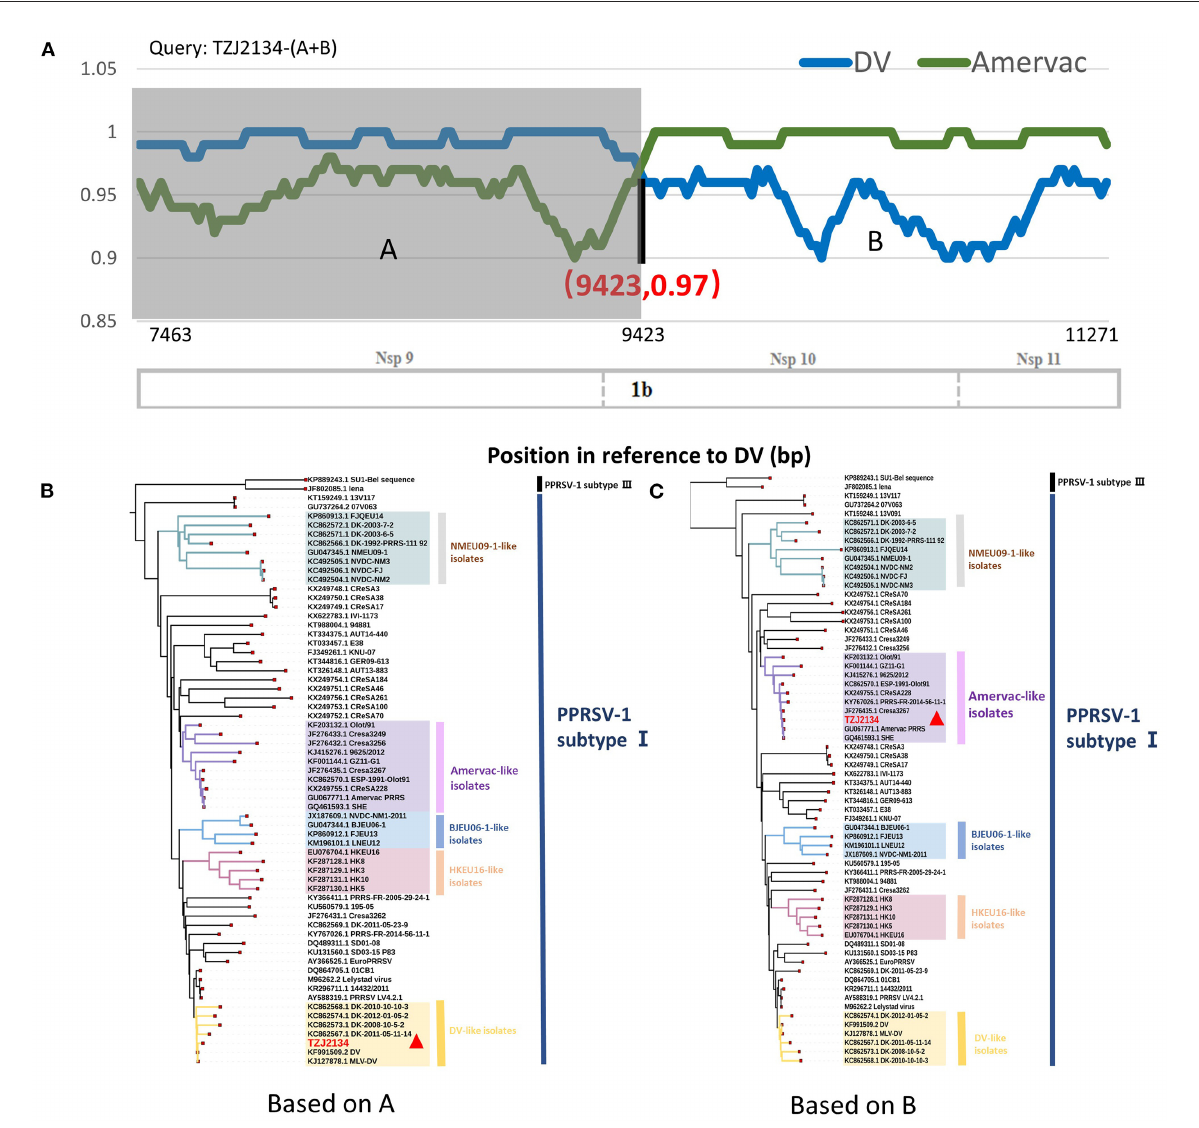
FIGURE2 Recombination analysis of TZJ2134-(A + B) and phylogenetic analysis of TZJ2134-A and TZJ2134-B. (A) Recombination analysis of TZJ2134-(A + B). Comparison was performed using TZJ2134-(A + B) as the query sequence and DV (blue) and Amervac (green) as the parent strains. The background color of the DV parental region is gray, whereas that of the Amervac parental region is white. Below the similarity plots is the partial genome structure of PRRSV, which shows the positions of three nonstructural proteins (Nsp9, Nsp10, and Nsp11). (B) Phylogenetic analysis of TZJ2134-A. The parental group (DV-like isolates) is shown in yellow. (C) Phylogenetic analysis of TZJ2134-B. The parental group (Amervac-like isolates) is shown in purple, and the query strain TZJ2134 is indicated with a red